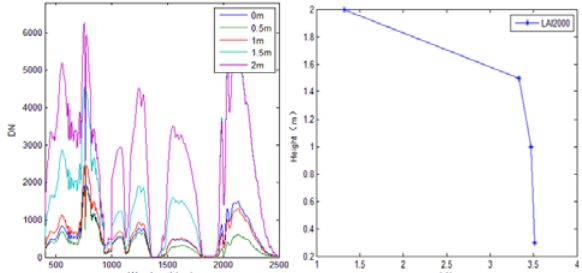
Figure 3. Experiment of measuring corn canopy transmissivity and LAI